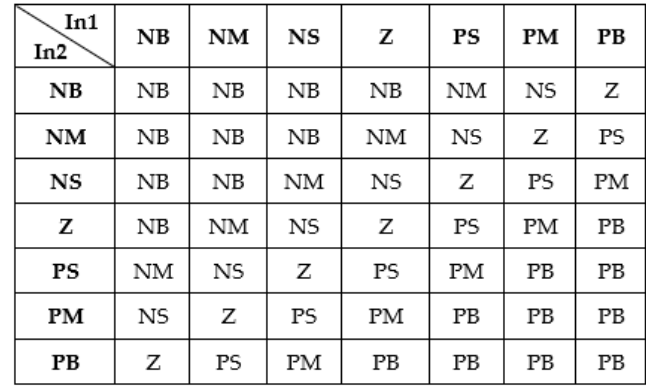
Figure 11. The inference rules for the “SpeedFIS”.